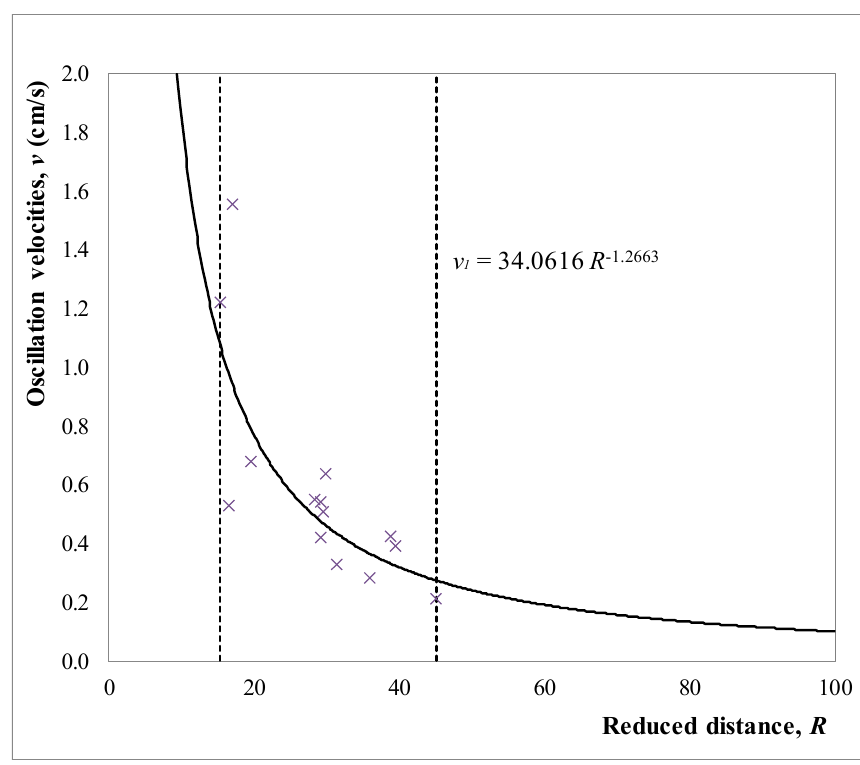
Figure 4. Minerals 2018 , 8 , x FOR PEER REVIEW